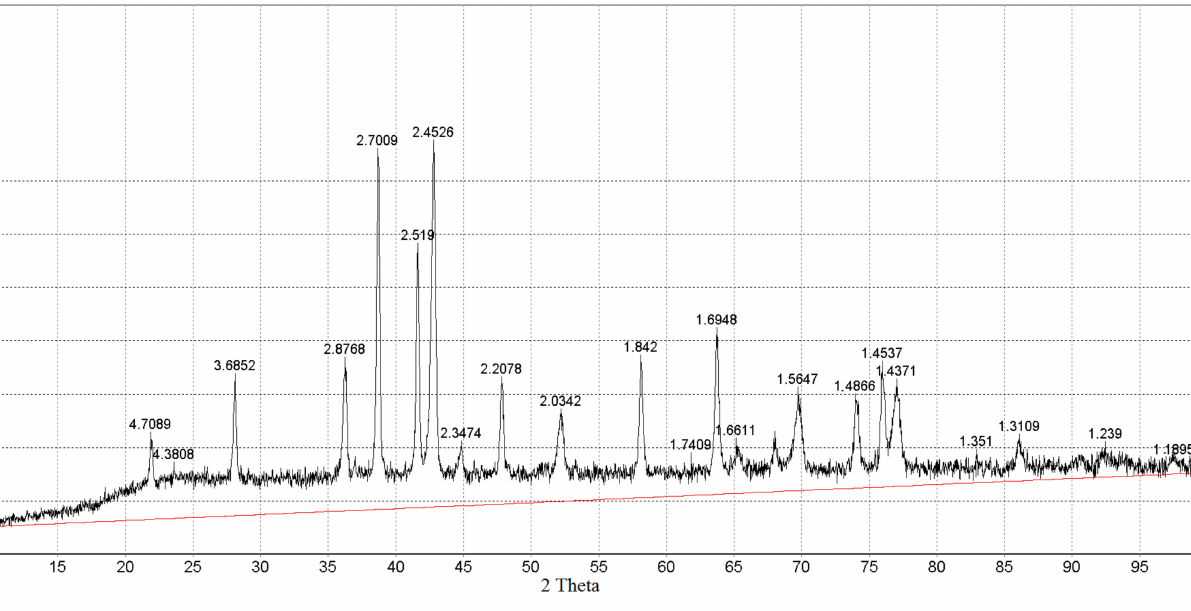
Figure 7. X-ray diffraction pattern of CoFe 2 O 4